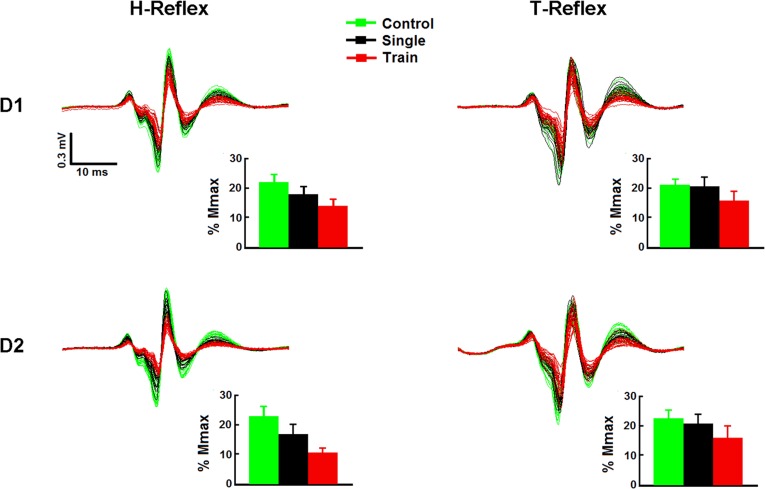
Raw data from one representative subject showing the effect of PSI on H- and T-reflexes at C-T intervals corresponding to D1 and D2.H- and T-reflexes are shown in the left and right panels, respectively. Each panel depicts 60 superimposed sweeps, including sweeps without conditioning (20 green traces, control reflexes), with single conditioning pulse (20 black traces, “single” responses) and conditioned by a train of pulses (20 traces in red, “train” responses) obtained from one subject. Bar graphs with the corresponding averaged reflex responses for this subject are also displayed. Care was taken to obtain control responses with similar amplitudes (20%Mmax) for both H- and T-reflexes (see the green bars). The effect of a single conditioning pulse on the T-reflex was noticeably weaker than that observed for the H-reflex (compare black and green bars), for both D1 (upper panels) and D2 (lower panels). Note the stronger effect of PSI induced by a train of stimuli as compared to a single conditioning pulse (compare red and black bars), for both reflexes regardless of D1 or D2 C-T intervals. The vertical traces indicate the standard error of the mean (SEM). The vertical and horizontal calibrations are identical for all sweeps.